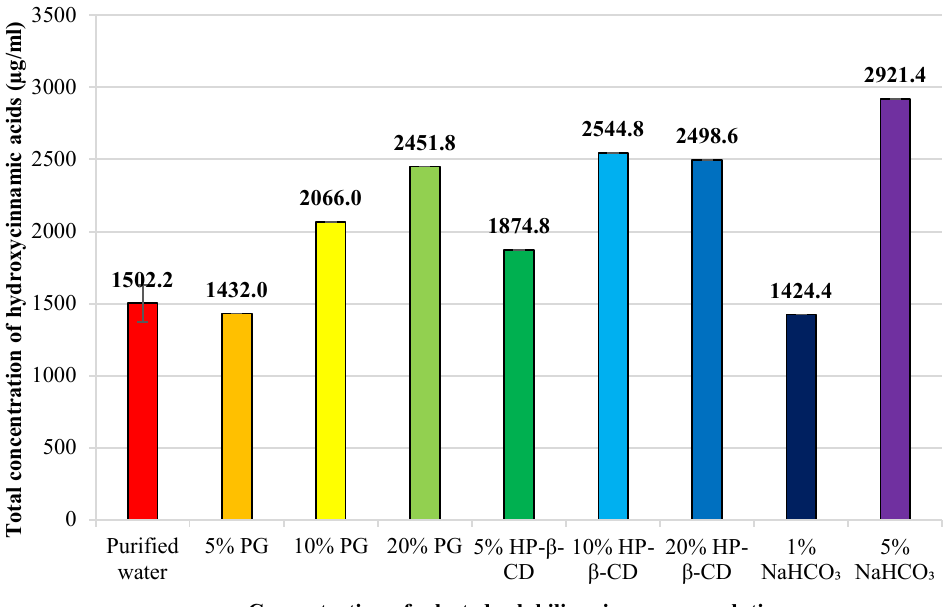
Figure 4. The effect of selected solubilizers on total concentration of hydroxycinnamic acids in aqueous solutions.